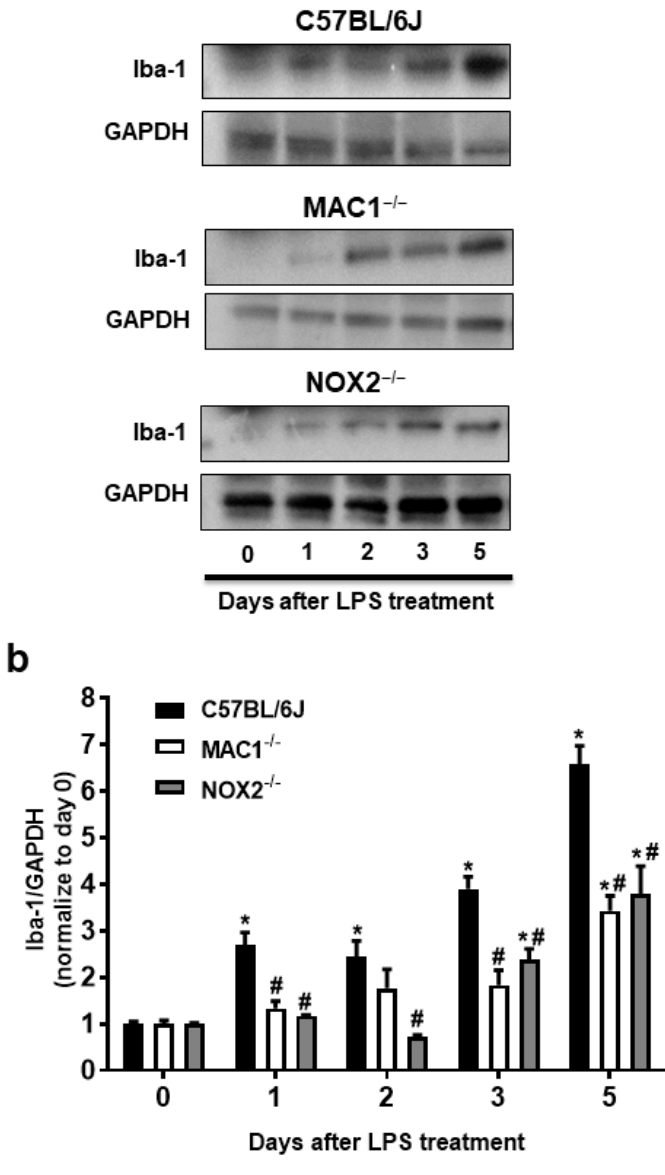
Figure 3. Reactive microgliosis was reduced in LPS-treated MAC1- or NOX-deficient neuron/glia cultures. ( a ) Neuron-glial cultures from wild type, MAC1 KO, and NOX2 KO mice were treated with LPS (20 ng/mL), and cell pellets were collected at various time points as indicated for Iba-1 detection. Quantification of Iba-1 in ( b ) wild type and MAC1 KO or wild type and NOX2 KO neuron-glial cultures. Data show mean ± SEM from 3 independent experiments. * p < 0.05; # p < 0.05.